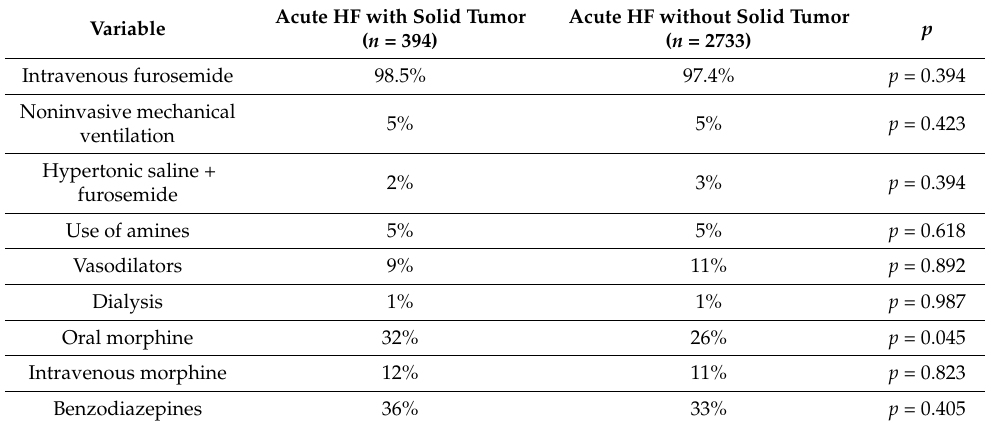
Table 3. Treatment received during admission in both groups.